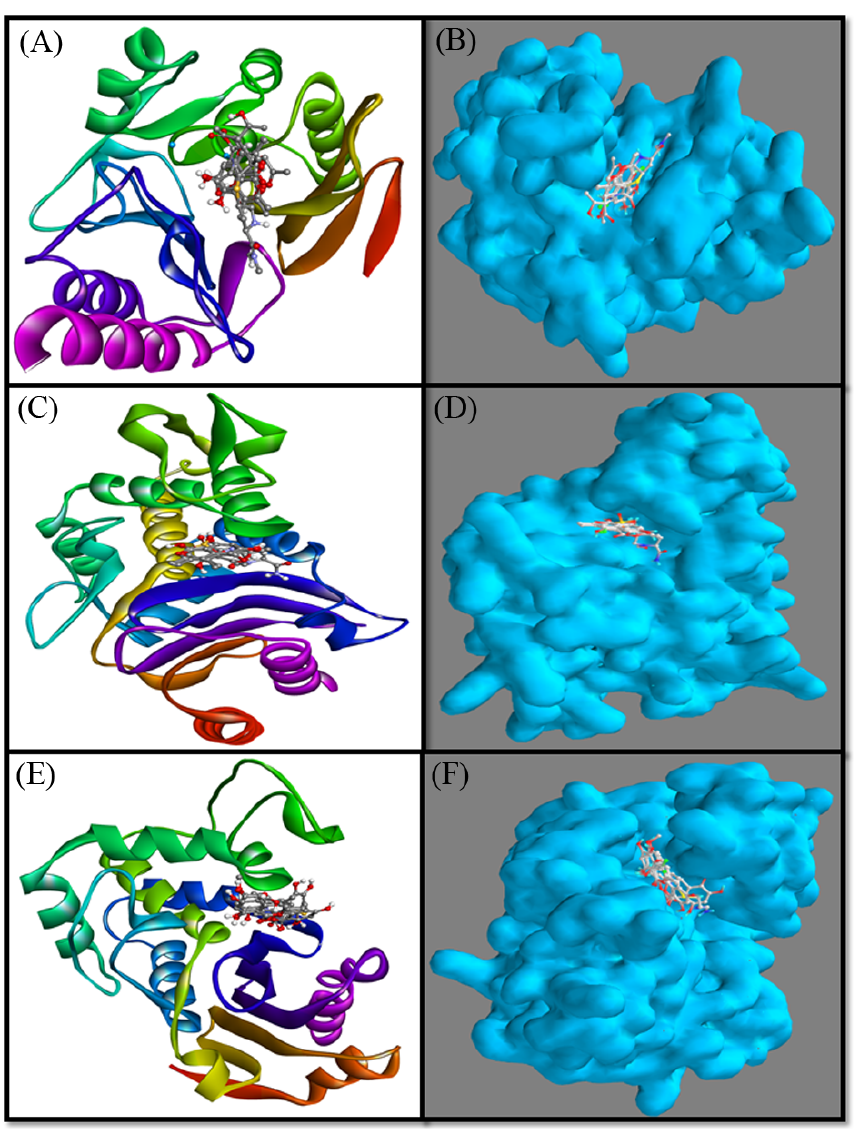
Figure 2. Cartoon and Van der Waals surface representation of meropenem ( A , B ), respectively, inside the active site of NDM-1; avibactam ( C , D ), respectively, inside the active site of CTX-M-15; and imipenem ( E , F ), respectively, inside the active site of OXA-48.